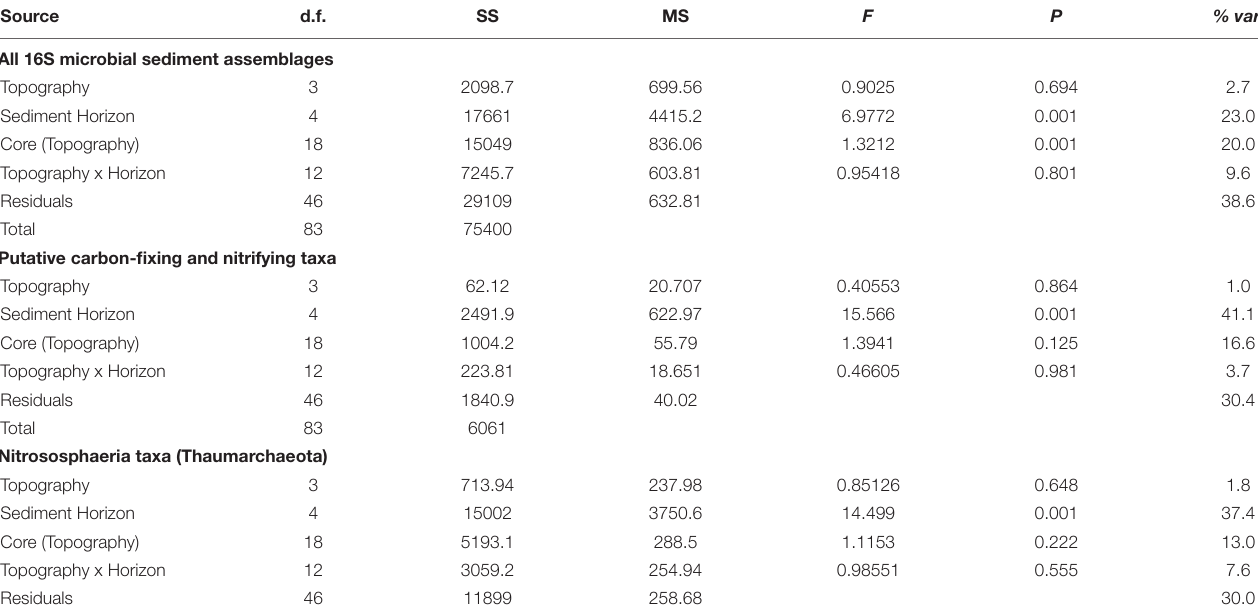
TABLE 2 | Output permutational multivariate analysis of variance (PERMANOVA) on relative abundance counts that have been square-root transformed prior to creation of Bray-Curtis dissimilarity matrices for sediment microbial assemblages at APEI-6, showing the following: all 16S microbial assemblages; putative carbon-fixing and nitrifying taxa within sediment microbial assemblages; and taxa within the Nitrososphaeria class in the Thaumarchaeota phylum.